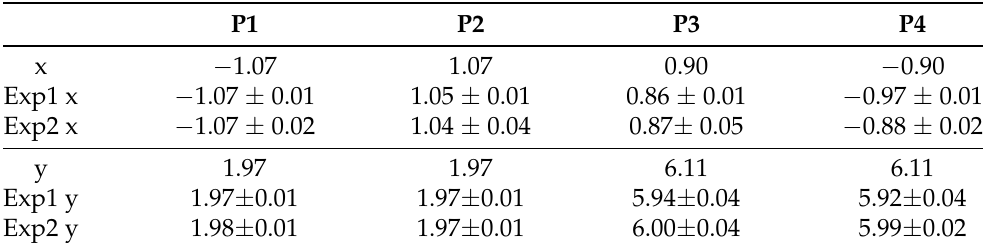
Table 1. Validation of the CoP estimation (all values in